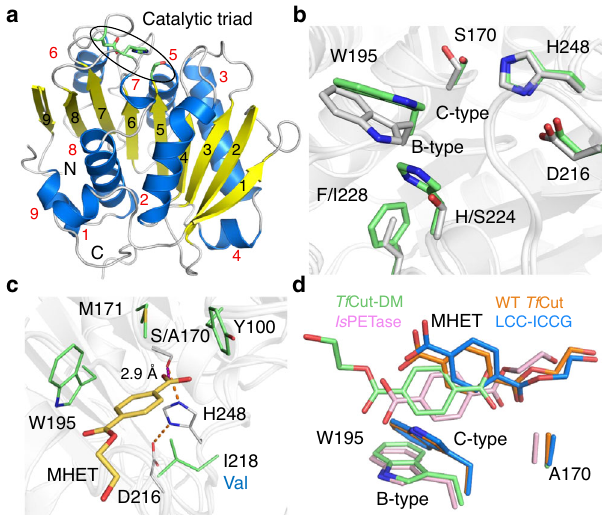
Fig. 3 | The MHET-bound Tf Cut-DM structure. a The X-ray crystal structure of Tf Cut-DM. Thenumbered α -helices, β -sheets,and loop regionsarecoloredinblue, yellow,andwhite,respectively.Threeaminoacidsthatconstitutethecatalytictriad are shown in green sticks and circled in black. b Superimposed residues in the activesiteof Tf Cut-DM(white,PDBID:7XTR)withWT Tf Cut(green,PDBID:5ZOA) displayedinsticks. c KeyresiduessurroundingMHETintheactivesiteareshownas green sticks. The alternative residue in LCCislabeledunder I218 in blue color. The catalytictriadresiduesareshownaswhitesticks.ResidueS170isfromtheWT Tf Cut (white stick,PDB ID: 5ZOA). d Comparisonofthe substrate-bindingposes between MHET-bound WT Tf Cut (orange, PDB ID: 7XTV), LCC-ICCG (blue, PDB ID: 7VVE), Tf Cut-DM (green, PDB ID: 7XTT), and Is PETase (pink, PDB ID: